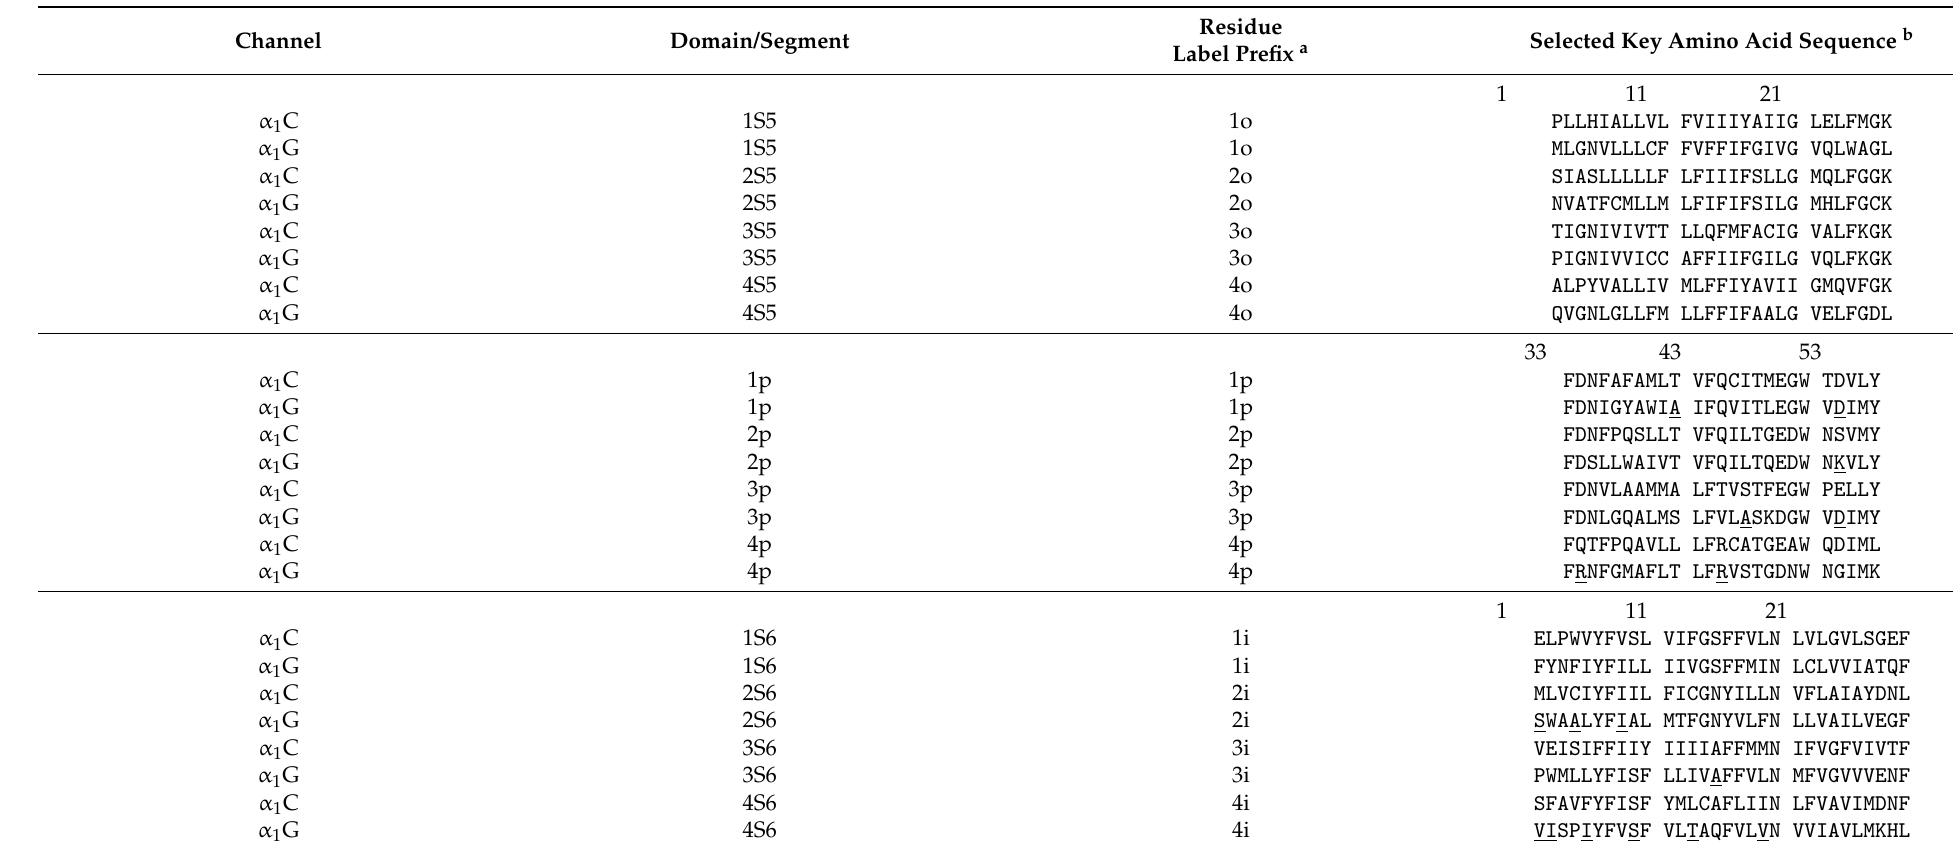
Table 4. Amino acid sequences of α 1 G used for searching the homology modeling